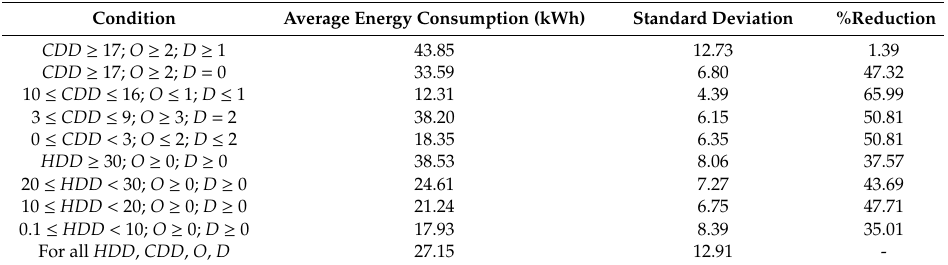
Table 9. Average energy consumption and standard deviation under various